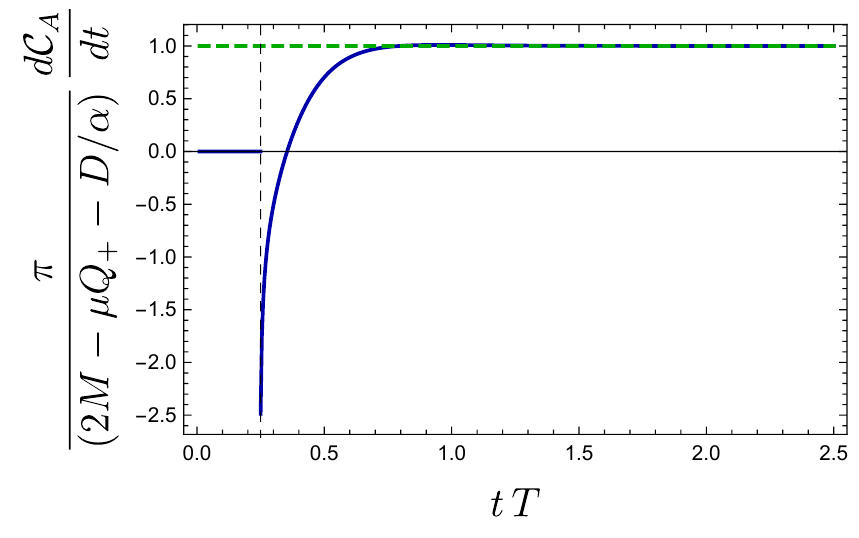
p 2, = L , L = 0 : 9, b = 0 : 75 and c = 2 : 5. ct , at times of the order of the ct